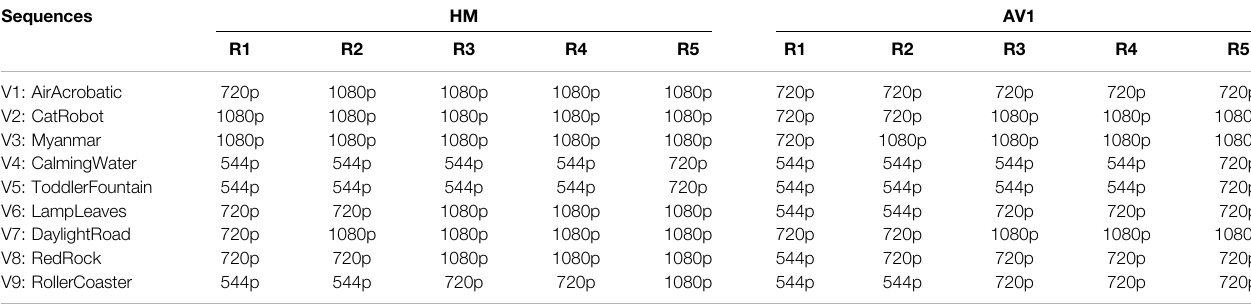
TABLE 2 | Resolution selections per sequence after applying the DO methodology on AV1 and HM for resolution group C. Sequences